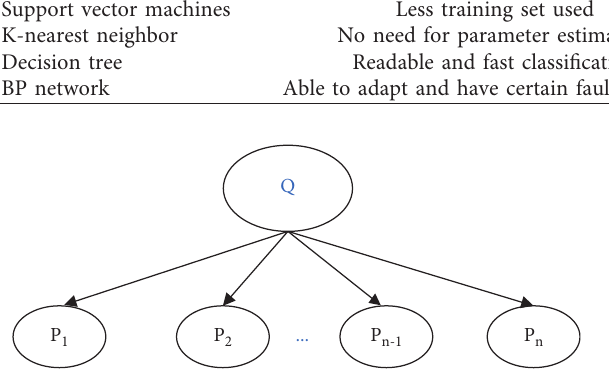
Figure 1: Naive Bayes classification